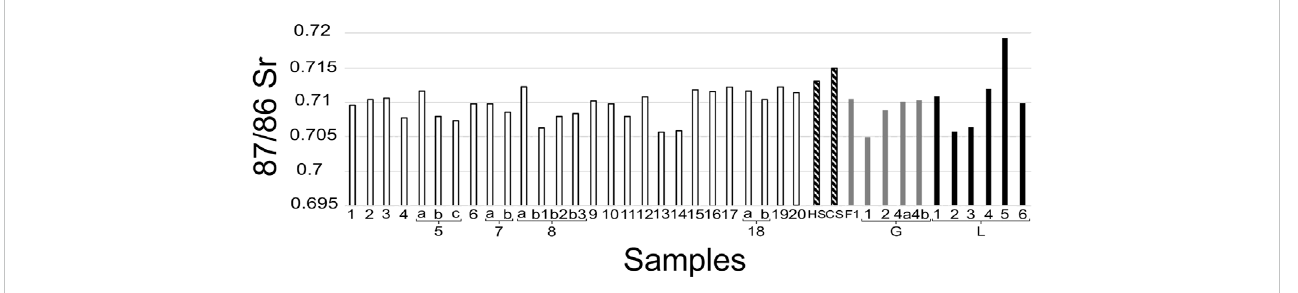
FIGURE 12 Plot of 87 Sr/ 86 Sr ratios for sampled carbonates (white bars), water springs (striped bars), cave materials (grey bars) and Miocene deposits (black bars).